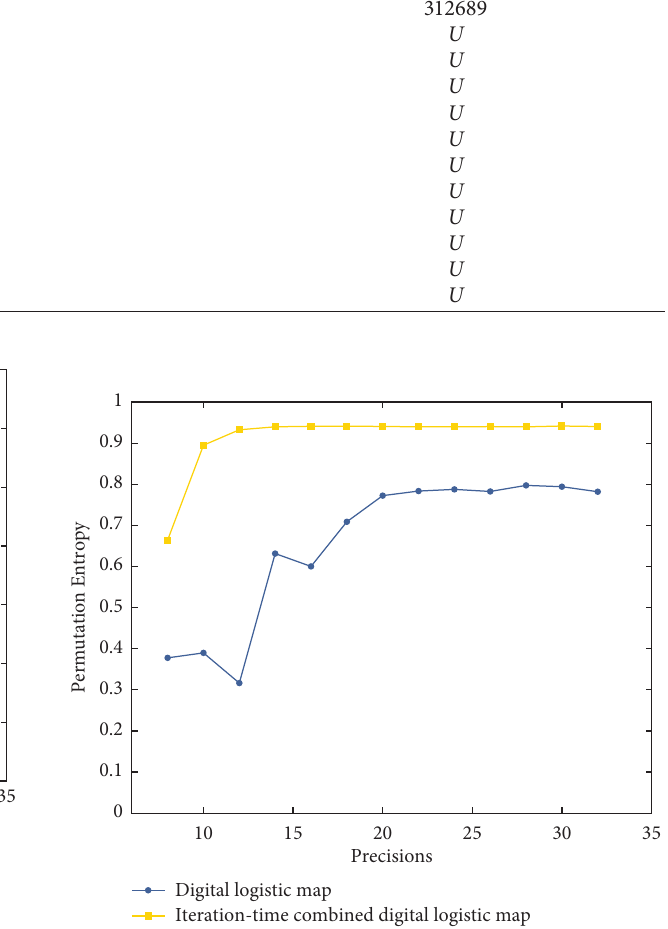
Figure 4: The ApEn of the digital logistic map, iteration-time combined digital logistic map, and coupled digital logistic map.